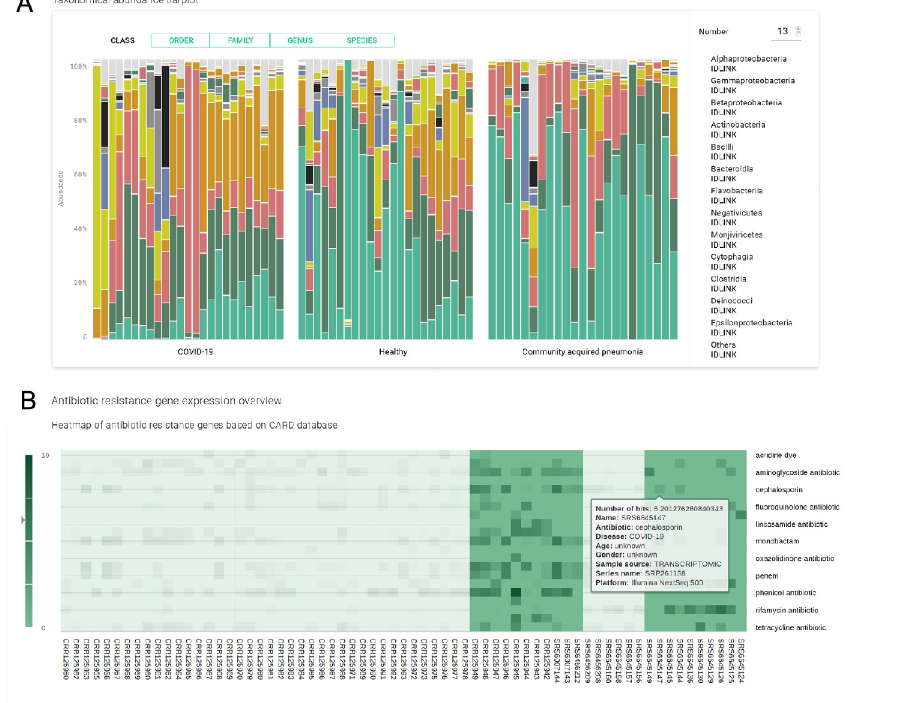
Fig 4. Overview of selected functionalities offered by the platform. (A) A bar plot shows the presence of the most common microbial classes, the number and level of the taxa could be specified by the user. (B) The heatmap shows the expression levels of the genes known to provide resistance to certain antibiotics. The dataset used to generate the plots was obtained from [33].